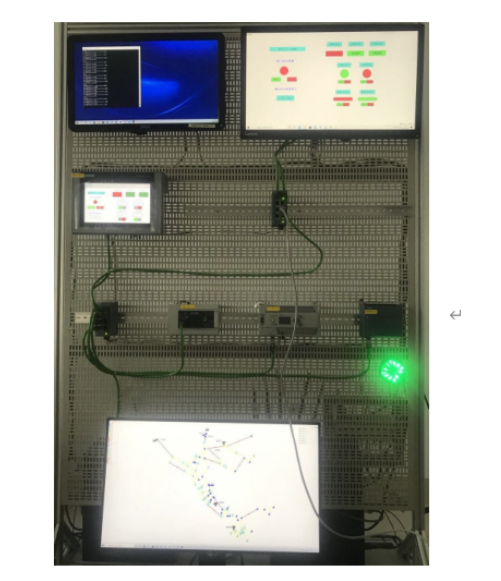
Figure 6. Experimental scene.